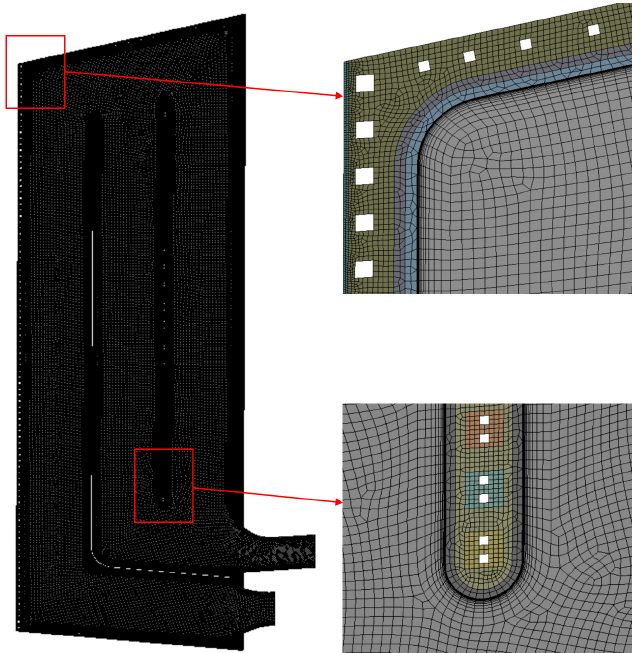
Figure 4. Mesh arrangement.